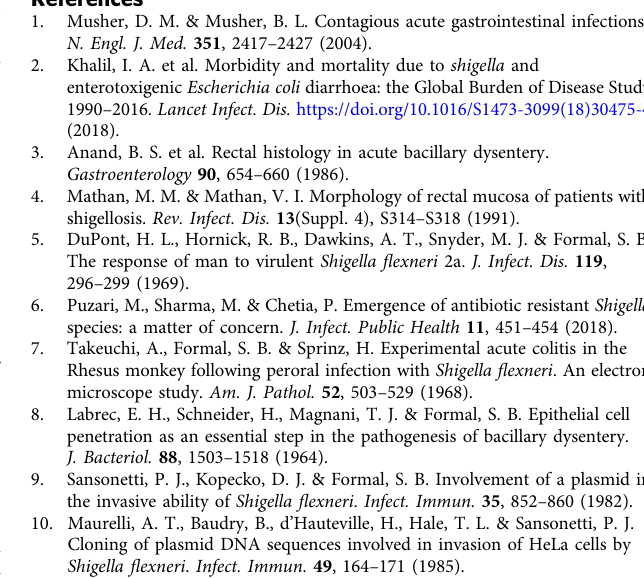
(not shown) and vascular lesions (doted black line) lead to the in fi ltration of